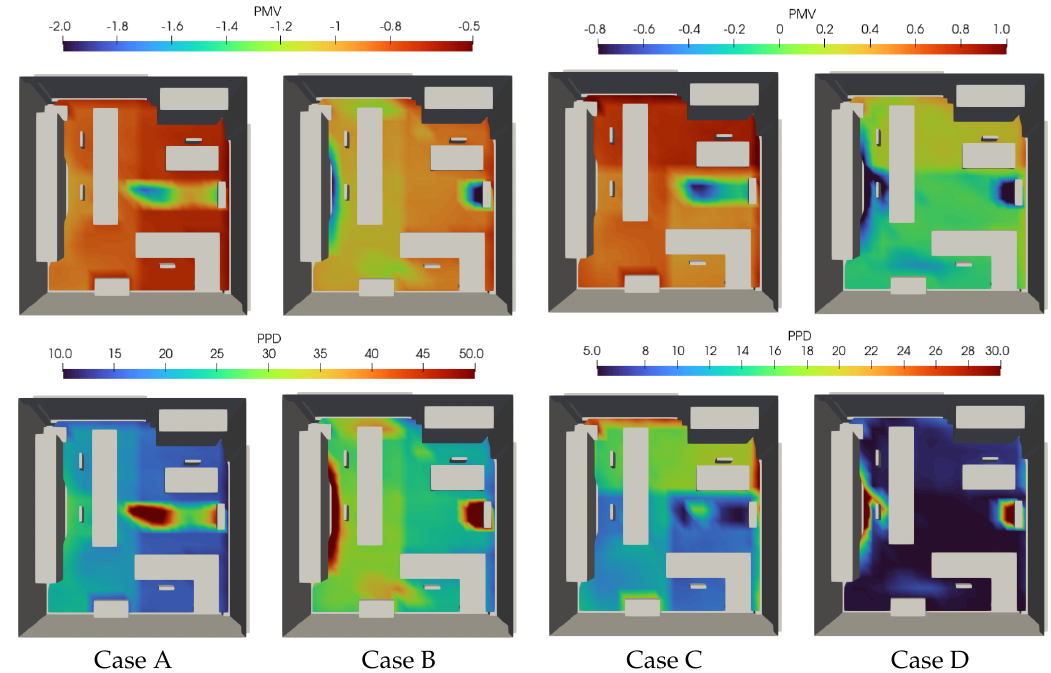
Figure 15. Summer cooling condition. PMV (top subfigures) and relative PPD (bottom subfigures) distributions in the office obtained for low input air velocity and no solar load (Case A), high input air velocity and no solar load (Case B), low input air velocity and solar load (Case C), high input air velocity and solar load (Case D).